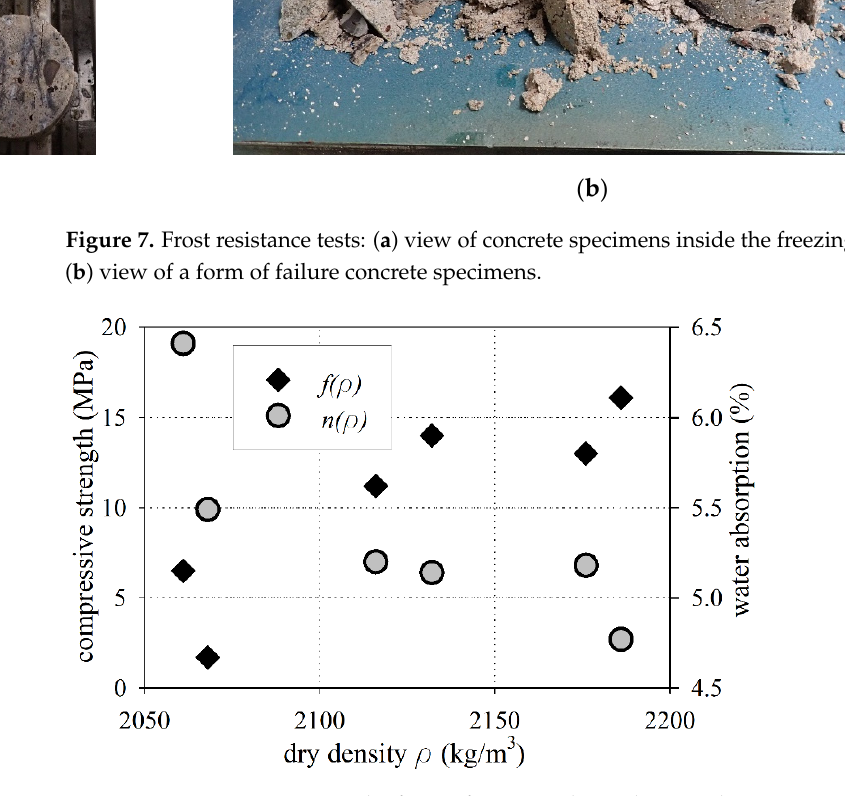
Figure 9. Modulus of elasticity in compression vs. dry density.